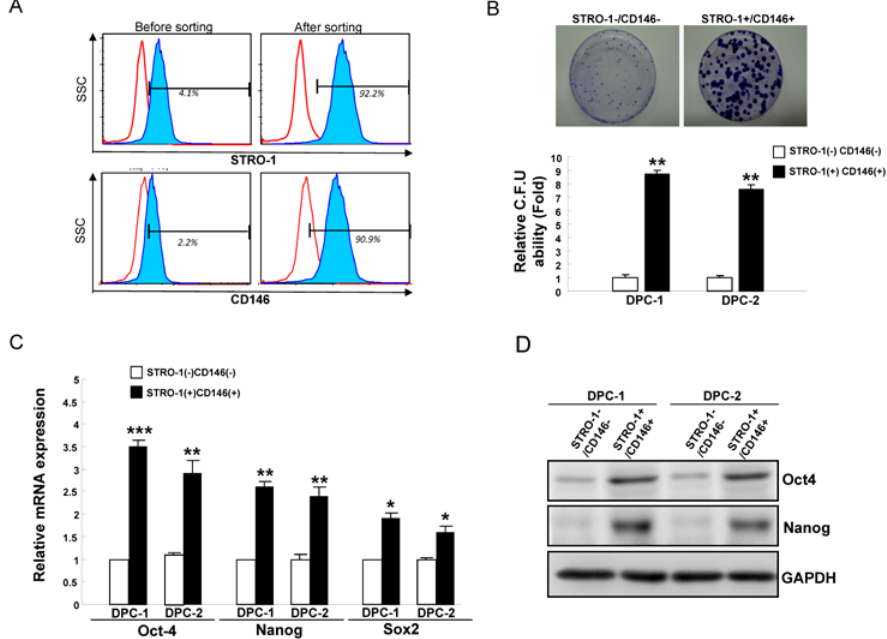
Figure 1. Enriched Oct4 and Nanog expression in STRO-1 + CD146 + DPSCs (Dental Pulp Stem Cells). ( A ) The expression of STRO-1 and CD146 in dental pulp cells was analyzed by flow cytometry; ( B ) To elucidate the capabilities of colony formation of STRO-1 − CD146 − and STRO-1 + CD146 + dental pulp cells, single-cell suspensions of dental pulp cells were plated and analyzed as described in the experimental section; Oct4 , Nanog , and Sox2 mRNA expression in STRO-1 + CD146 + and STRO-1 − CD146 − dental pulp cells were examined by real-time RT-PCR analysis ( C ) and western blotting analysis ( D